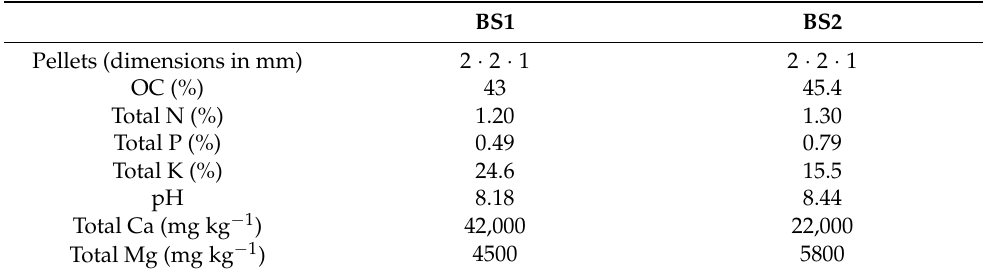
Table 1. The basic chemical and physical properties of soil before the establishment of the experiments. Doln á Streda Vel’k é Ú l’any Soil Property Sandy Haplic Arenosol Loamy Vermic Chernozem (Arenic, Calcic) (Mollic, Loamic) Sand (%) 81.9 38.5 Silt (%) 10.5 47.8 Clay (%) 7.60 OC (g kg − 1 ) Total N (mg kg − 1 ) 1000 Available P (mg kg − 1 ) 175 129